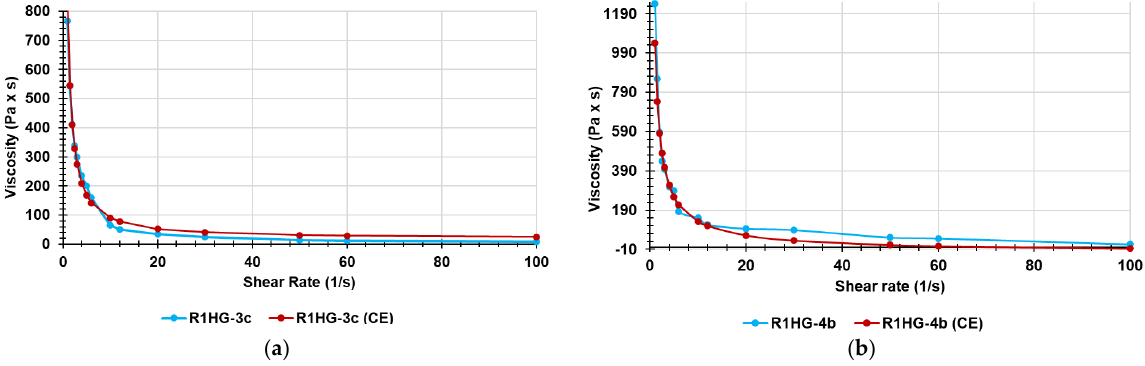
Figure 16. Relationships between the viscosity and the shear rate by Cross fitting using the proposed method for R1HG-3c ( a ) and R1HG-4b ( b ) (red lines) and the experimental measurements (light blue lines).